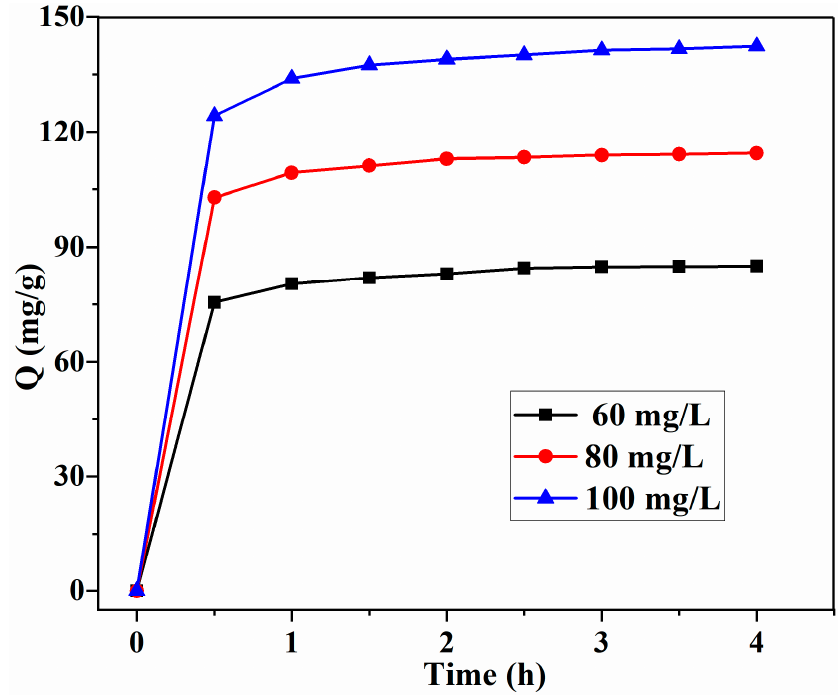
Figure 7. Effect of initial concentration and contact time on the adsorption capacity with SA/Lig- beads ( m = 20 mg, V = 200 mL, pH = 12, T = 45 ◦ C, s = 20% beads ( m = 20 mg, V = 200 mL, pH = 12, T = 45 °C, s = 150r/min).